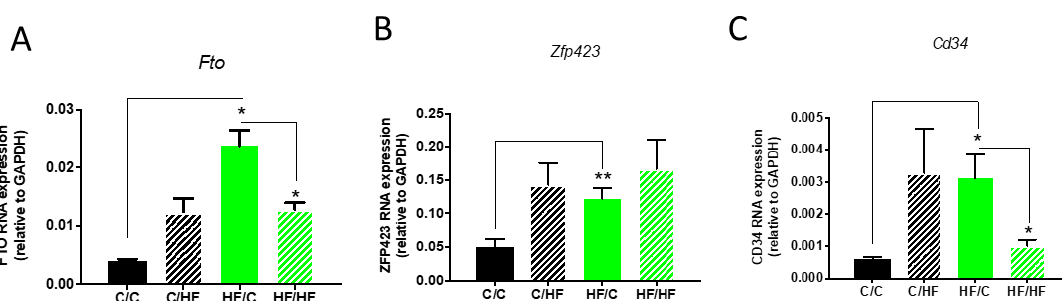
Figure 4. Fto ( A ), Zfp423 ( B ), and Cd34 ( C ) RNA expression in gWAT of female chow (C)- or high-fat (HF)-fed 30-week old offspring of dams fed a chow C or HF diet for 6 weeks prior to pregnancy and during pregnancy and lactation. All data represent means ± SEM. Data was analysed by ANOVA and Tukey’s multiple comparison test. N = 5–7. * p < 0.05, ** p < 0.01, *** p < 0.001, **** p < 0.0001.